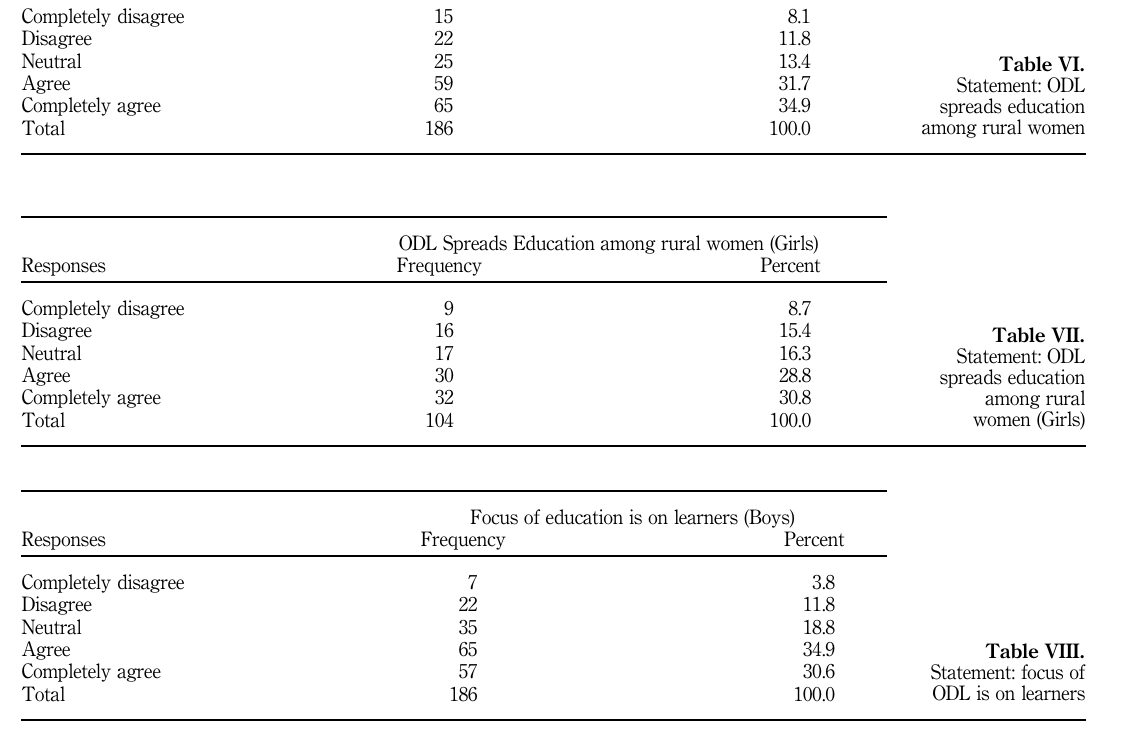
Table VI. Statement: ODL